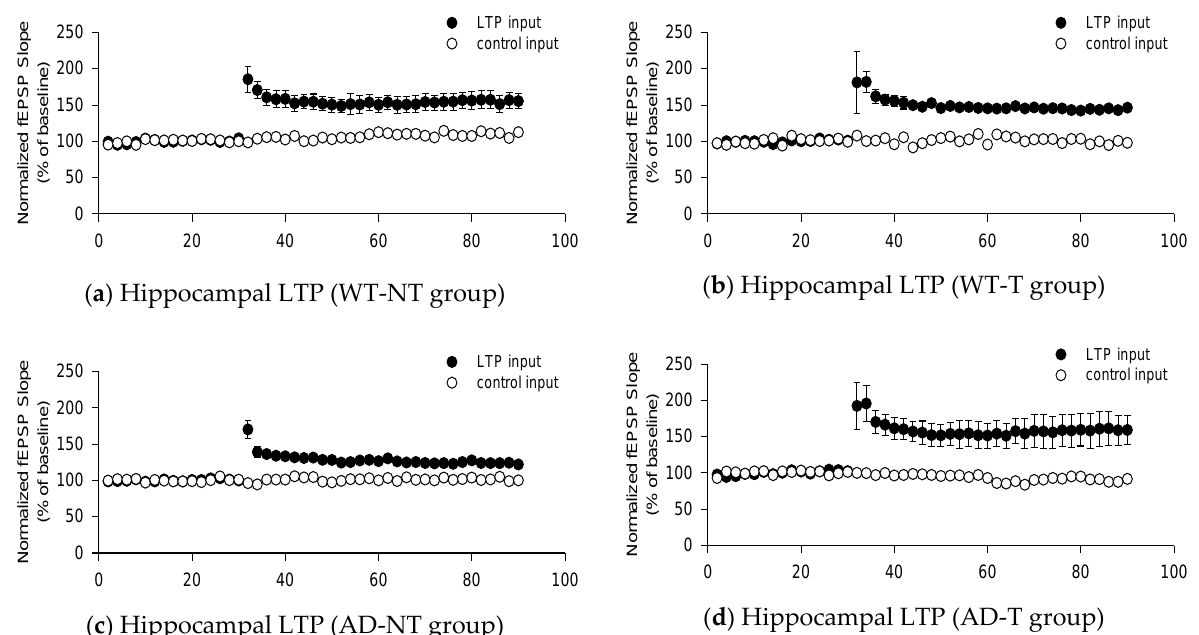
Figure 1. The graphs show the field excitatory postsynaptic potential (fEPSP) responses in each group. High-frequency stimulation are delivered at 30 min for long-term potentiation (LTP). ( a ) fEPSP in the hippocampal region of wild-type mice that did not receive transcranial alternating current stimulation (tACS). ( b ) fEPSP in the hippocampal region of wild-type mice that received tACS. ( c ) fEPSP in the hippocampal region of 5 familial AD mutation (5xFAD) mice that did not receive tACS. ( d ) fEPSP in the hippocampal region of 5xFAD mice that received tACS. The white dots are the baseline fEPSP slopes, and the black dots are the main results of the fEPSP slope stimulated by high frequency. The fEPSP slope was remarkably increased in the AD-T group ( d ) compared to that in the AD-NT group ( c ) ( p -value = 0.003). In addition, the fEPSP slope was higher in the WT-T group ( b ) ( p -value = 0.001) and WT-NT group ( a ) ( p -value = 0.000) than in the AD-NT group ( c ). However, there were no significant differences among the other groups. The data from each group show mean values and standard errors (SE). For statistical analysis, the Kruskal–Wallis test and the Bonferroni method for post hoc analysis were used.